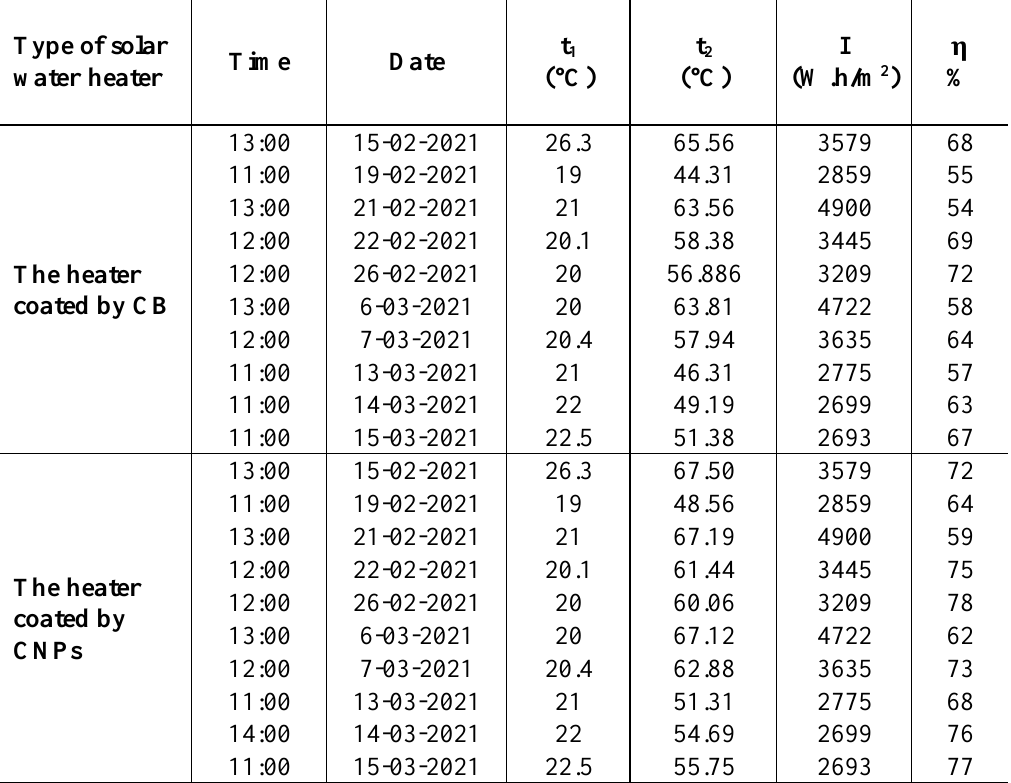
Table 1: The calculated thermal efficiency of the fabricated solar heaters T1 and T2 for 10 days, and for specific